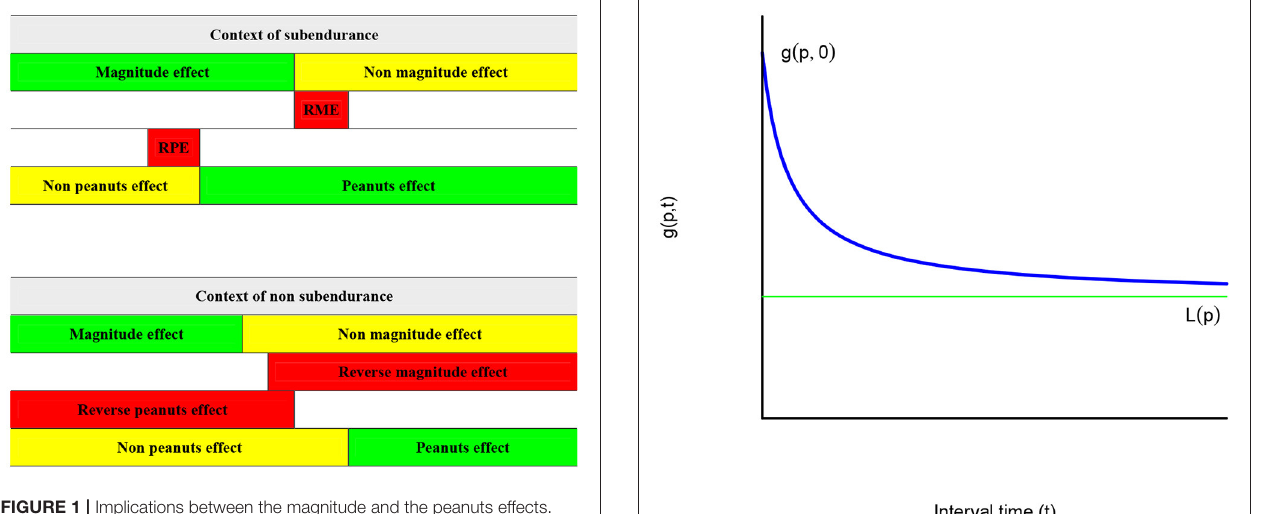
FIGURE 1 | Implications between the magnitude and the peanuts effects. Green denotes de presence of the mentioned effect. Yellow denotes de absence of the indicated effect. Red represents the existence of the reverse of the mentioned effect. Source: own elaboration.